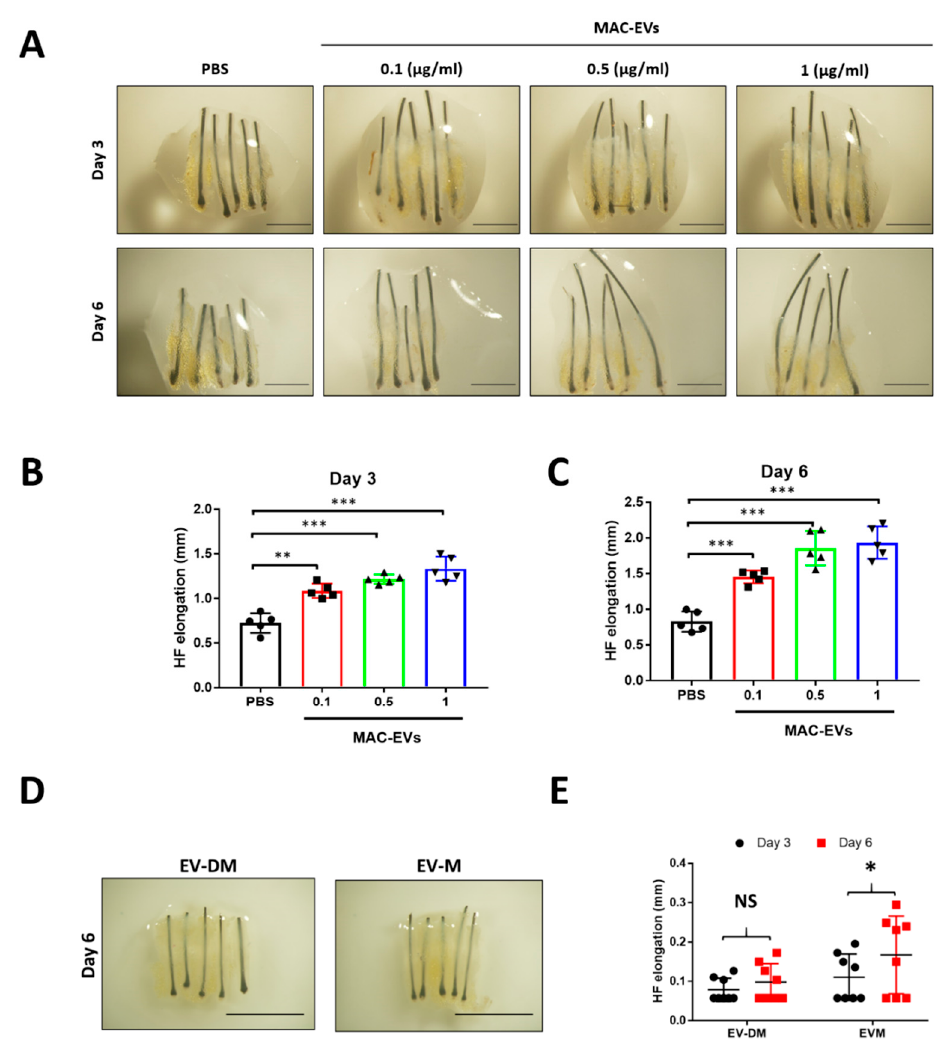
Figure 8. MAC-EVs promote hair follicle shaft elongation in human hair follicles. ( A ) Representative photographs of human hair follicles after PBS and MAC-EV treatment (0.1, 0.5, 1 µ g / mL) (scale bar: 1 mm). ( B , C ) Quantified data of hair shaft elongation on day 3 and day 6 ( n = 5). ( D ) representative photographs of human hair follicles after EV-DM and EV-M treatment (0.1, 0.5, 1 ( µ g / mL) (scale bar: 1 mm). ( E ) Quantified data of hair shaft elongation on day 3 and day 6 ( n = 8). Means ± SD of experiments are shown. * p < 0.05; ** p < 0.01; *** p < 0.001 Student’s t-test was used. EV-M; media containing EVs; EV-DM; media containing no